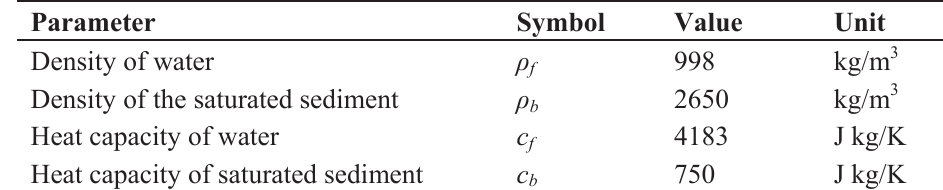
Table 2. Physical parameters used in the analytical calculation for the vertical water flow velocity of the